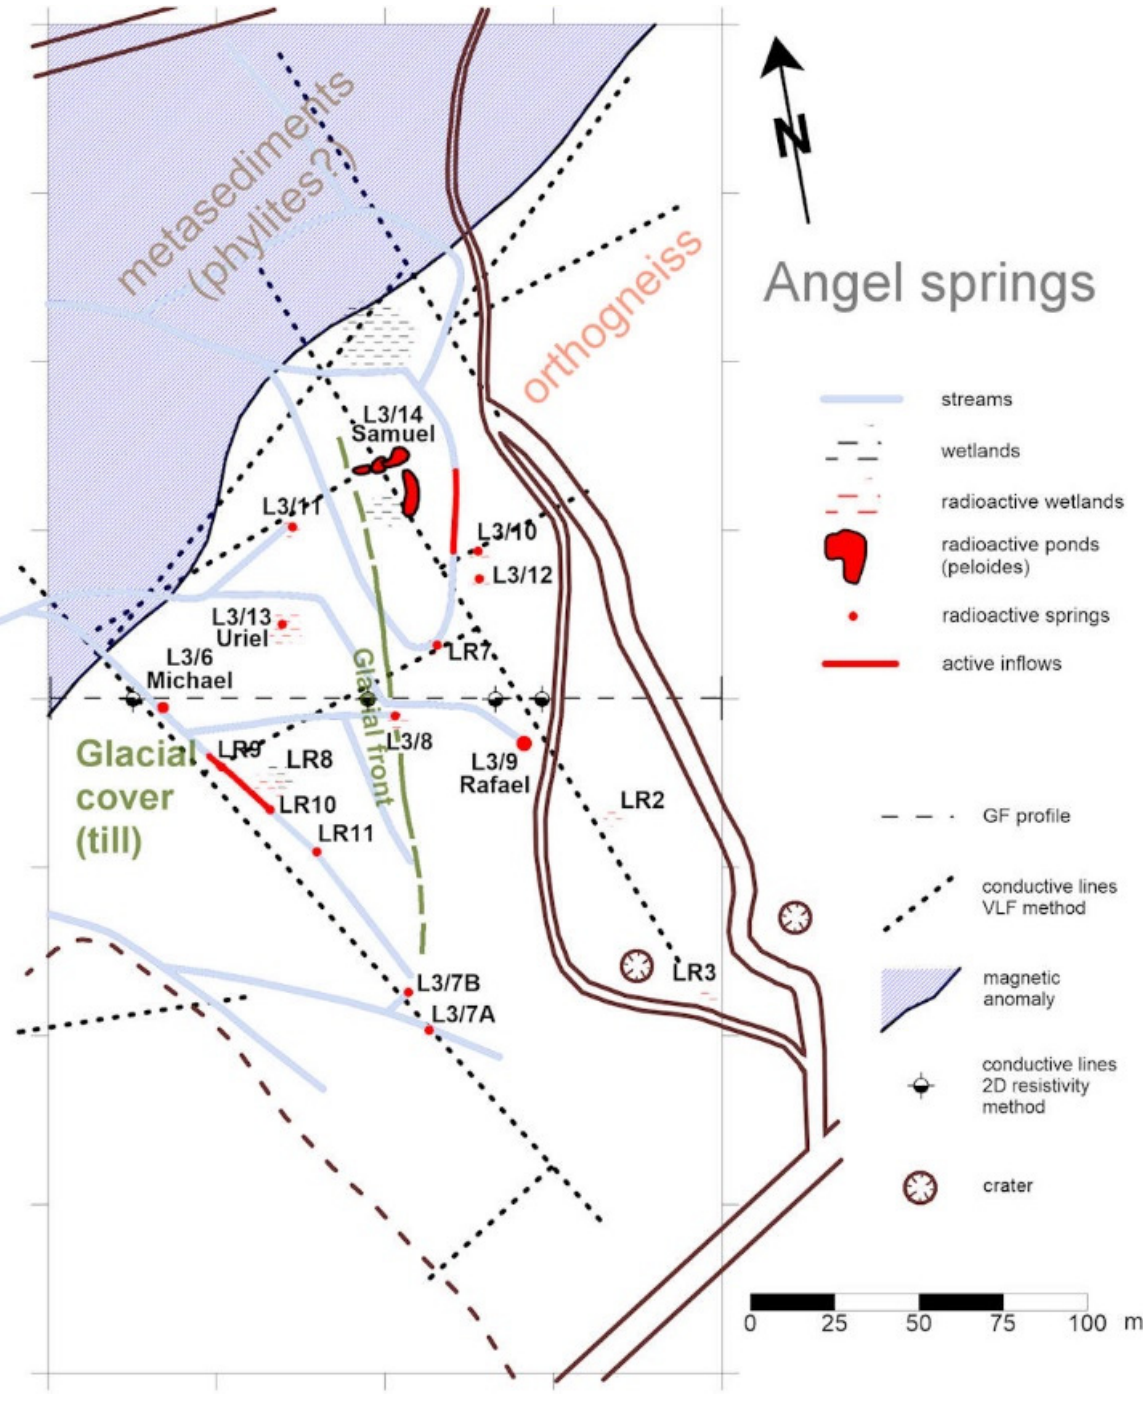
Figure 11. Locality of the Angel springs near Nové M ě sto p. Smrkem. Situation of the radioactive sources with interpretation of geophysical survey.